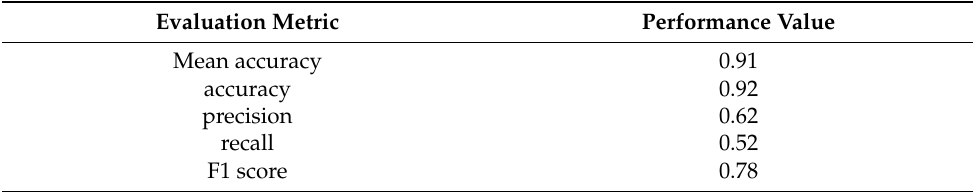
Table 3. Evaluation metrics of the proposed model.